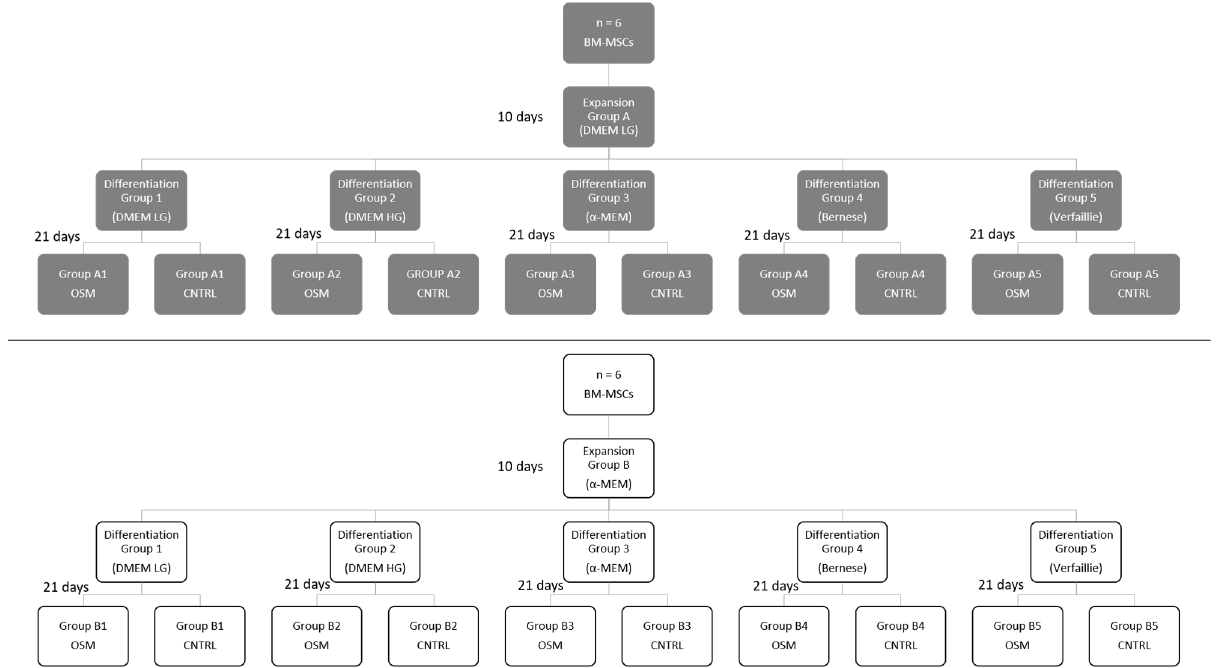
Figure 1. Overview of all 20 groups used in this study. Cell expansion in group A or group B for a duration of 10 days, followed by subsequent differentiation in one of the five differentiation media for 21 days in OSM and CNTRL. OSM = osteogenic media, CNTRL = control group.